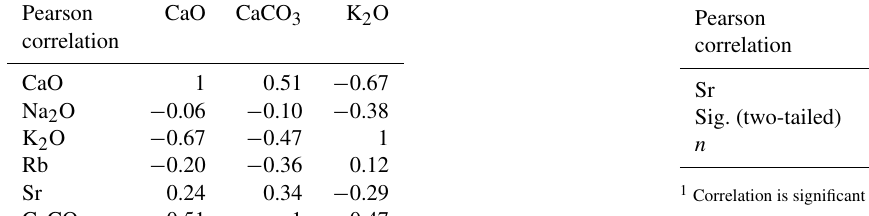
Table 2. Correlation coefficients for geochemical data for the XSZ section. Pearson CaO CaCO 3 K 2 O